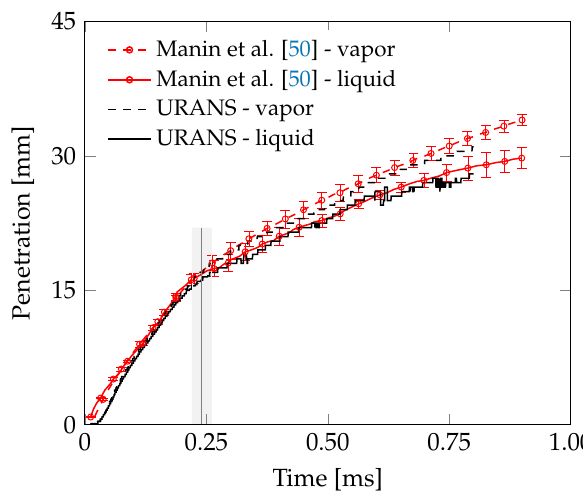
Figure 4. Liquid and vapor penetrations as predicted by URANS simulation in comparison with experimental data of SNL reported in Manin et al. [50]. The gray band corresponds to the time interval in which the separation between vapor and liquid phases occurs, as predicted by the numerical